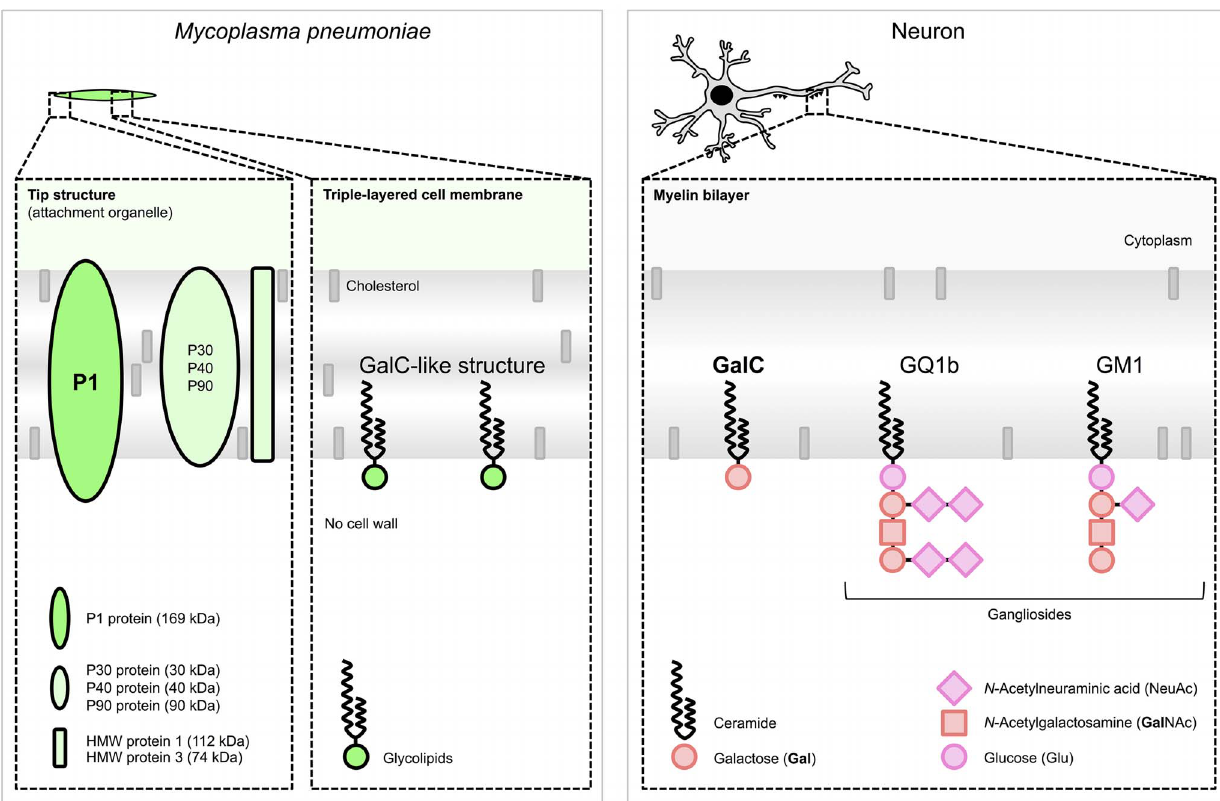
Figure 2. Schematic structures responsible for molecular mimicry between M.pneumoniae and neuronal cells. (Left) M. pneumoniae adhesion proteins and glycolipids. The immunogenic and major cytadherence proteins P1 and P30 are densely clustered at the tip structure. The P1 protein [31] and glycolipids, e.g., those forming a GalC-like structure [32], elicit cross-reactive antibodies induced by molecular mimicry. (Right) Host myelin glycolipids, to which antibodies were found in patients with M. pneumoniae encephalitis. Glycolipids are organized in specialized functional microdomains called ‘‘lipid rafts’’ and play a part in the maintenance of the cell membrane structure. Abbreviations: GalC, galactocerebroside C; GQ1b, ganglioside quadrosialo 1b; GM1, ganglioside monosialo 1 (the numbers stand for the order of migration on thin-layer chromatography, and the lower-case letters stand for variations within basic structures); HMW, high-molecular-weight. Structures of M. pneumoniae adhesion proteins and host glycolipids are adapted from [33] and [34],